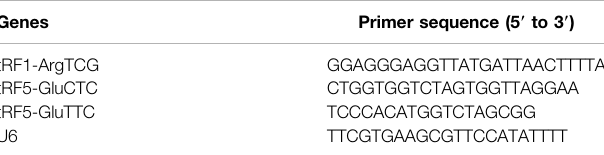
TABLE 2 | tRF primer